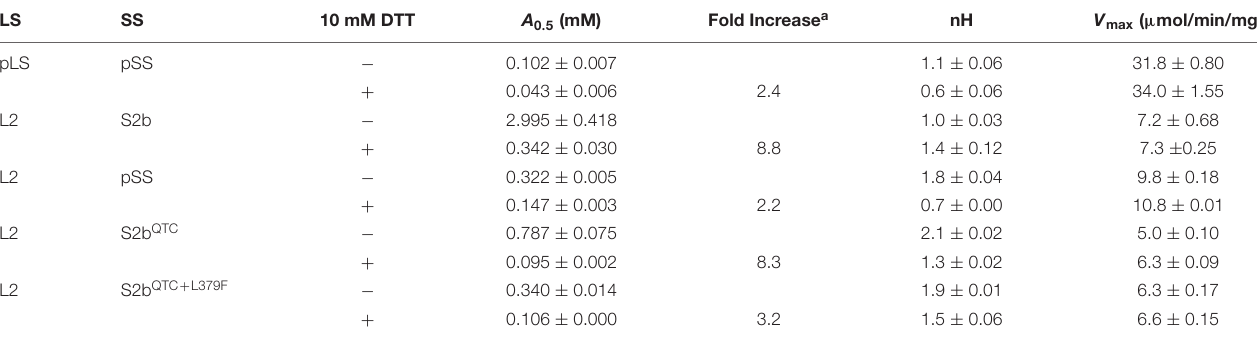
TABLE 3 | 3-PGA sensitivities and reductive activation of AGPase